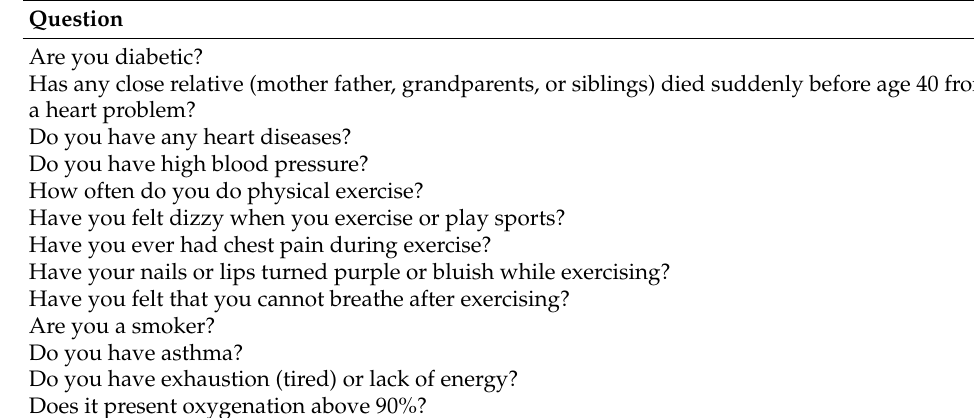
Table 4. Core questions on cardiovascular and respiratory conditions.